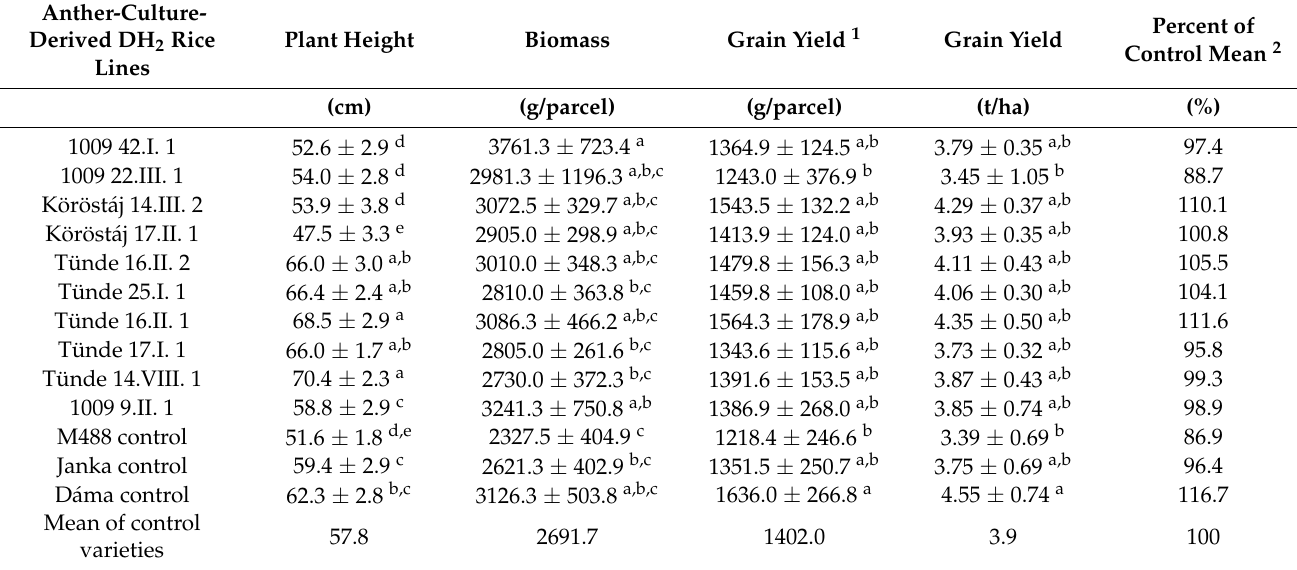
Table 7. Main phenological and agronomic parameters of anther-derived DH 2 lines in small-scale field experiment (Szarvas, Hungary, 2019–2020). The different alphabets (a–e) mark significantly different values ( p < 0.05) among the